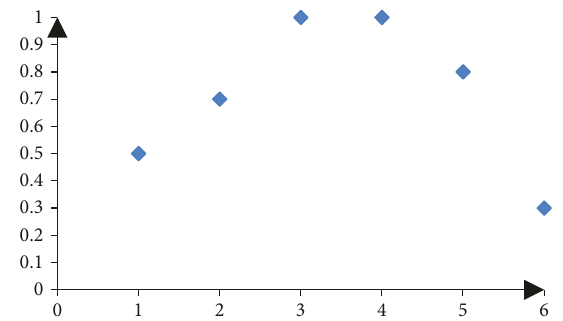
Figure 1: Graphical representation of a general discrete fuzzy number with support 1, … , 6 and core 3, 4